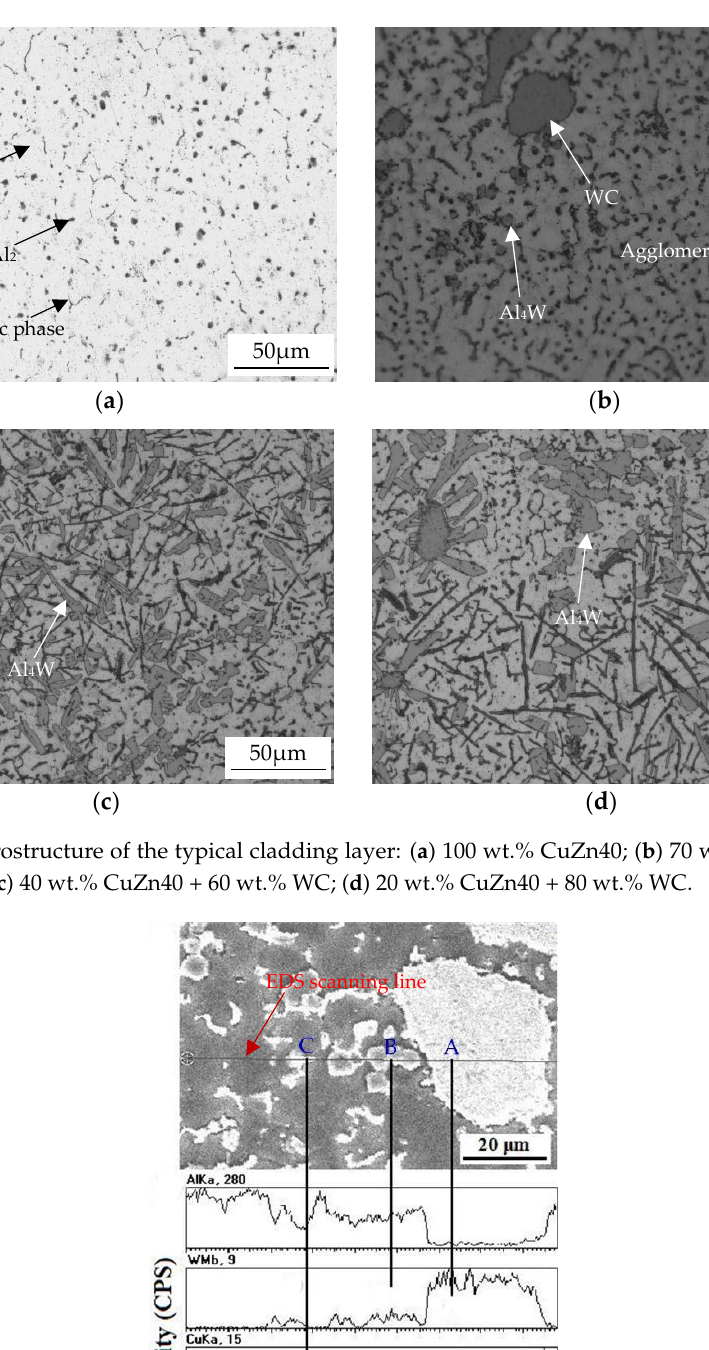
( b ) Figure 6. Morphology of the cladding layer cross-section: ( a ) Typical morphology; ( b ) effect of WC proportion in CuZn40-WC powders on cladding layer cross-section. 3.2. Microstructure of Cladding Layer The microstructures of the cladding layers prepared by the argon-shielded arc cladding of the CuZn40-WC powders with different proportion components are indicated in Figure 7. While the cladding powder was 100 wt.% CuZn40 powder, the microstructure of the cladding layer was homogeneous, which was similar to that of the aluminum substrate, as shown in Figure 7a, and the cladding layer was comprised of α-Al solid solution (containing Cu and Zn elements) and a small amount of Al-Cu compound. While the low proportion (≤30 wt.%) of WC powder was mixed with CuZn40 powder and used to clad, the cladding layers were also mainly comprised of α-Al solid solution. However, there were small amounts of agglomerated CuZn40 and WC powders in the cladding layers, as shown in Figure 7b. Figure 8 shows the SEM microstructure and EDS analysis results of line scanning in the typical local zone of Figure 7b. The results indicated that there were large amounts of W and Zn elements and small amounts of Cu and Al elements, which should be